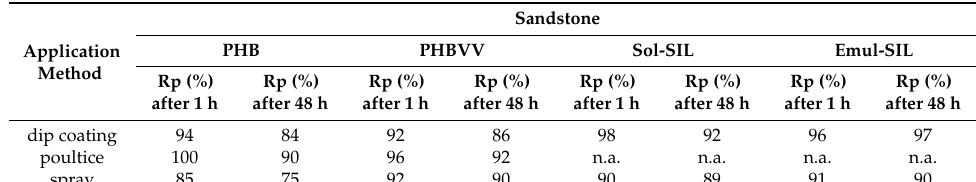
Figure 3. Water absorption curves of sandstone samples treated with: ( a ) PHB-based formulation by dip coating, poultice and spray and of untreated samples (duplicate samples for each condition); ( b ) PHBVV-based formulation by dip coating, poultice and spray and of untreated samples (duplicate samples for each condition). Table 3. Determination of the mean ratio of protection ( Rp , %) for treated samples of sandstone after 1 h and after 48 h of capillary absorption test.